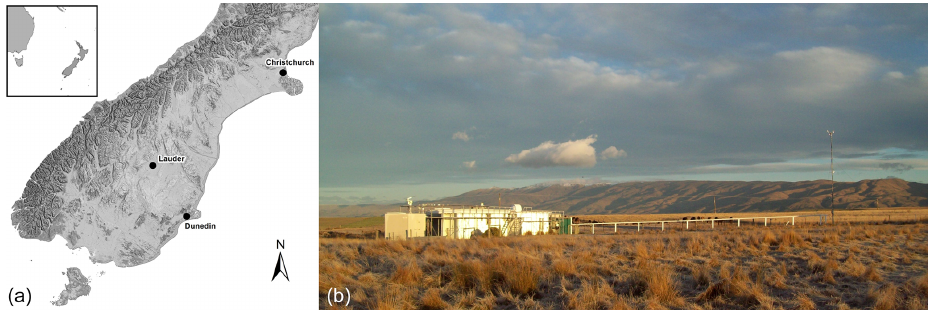
Figure 1. (a) Location of Lauder, South Island, New Zealand. (b) A westward view of the in situ sampling mast and the building housing the in situ